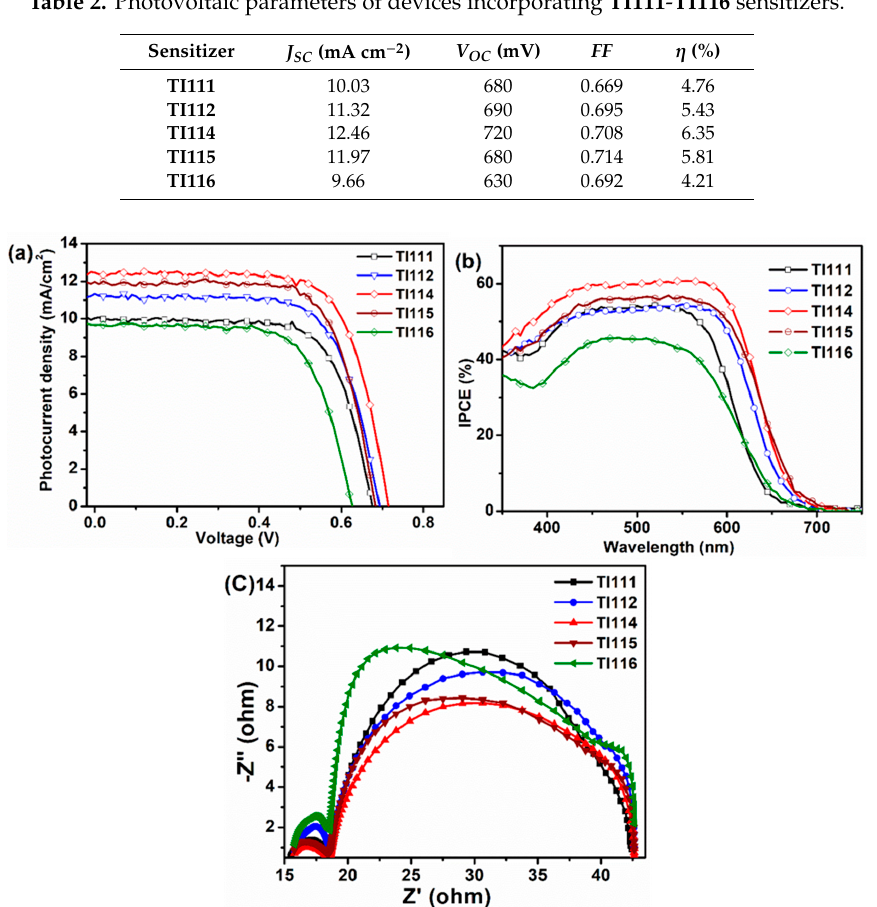
Figure 4. ( a ) Current versus potential plots and ( b ) Monochromatic IPCE spectra for sensitizers TI111 – TI116. ( c ) EIS spectra measured under illumination of DSSCs based on TI111 – TI116 dyes.